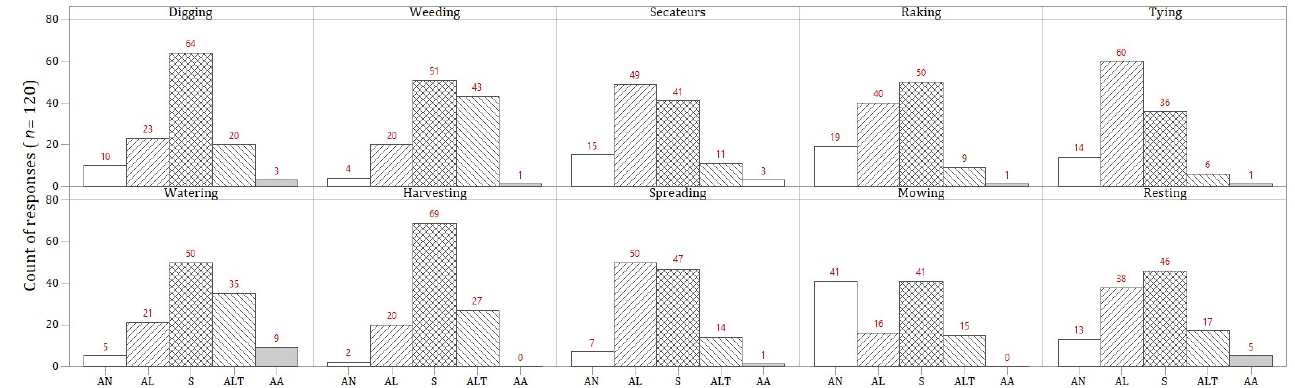
Figure 2. Histogram of responses (counts) describing the amount of time gardeners spend engaged in different activities. Key: AN = ‘almost none’, AL = ‘a little’, S = ‘some’, ALT = ‘a lot’ and AA = ‘almost all’. Bars show counts in each category out of 120. Non-responses are not recorded in the figure but amounted to a maximum of three for any one category.